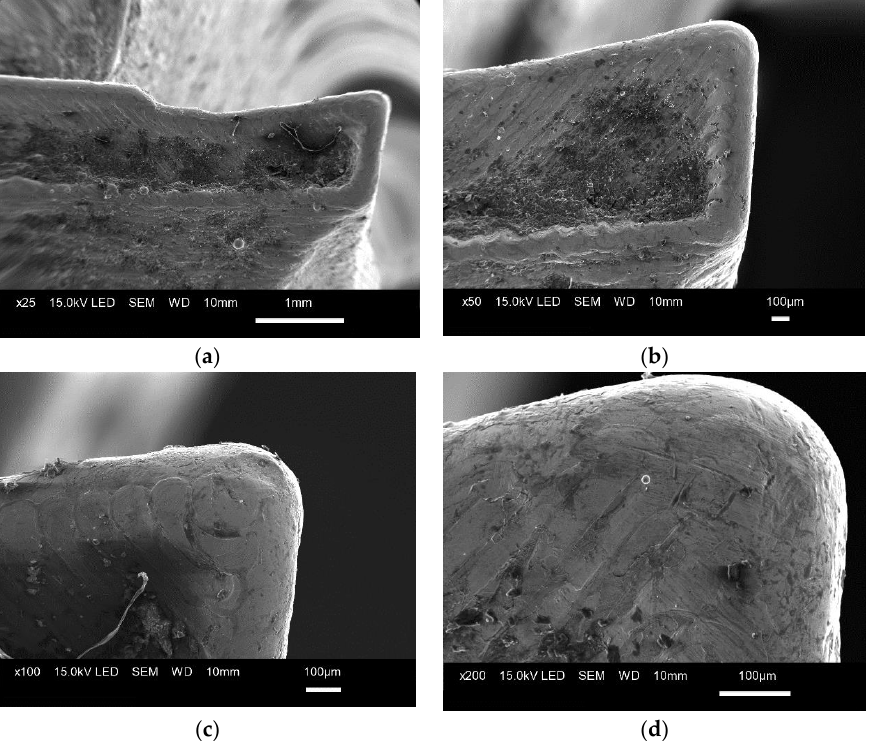
Figure 14. Microscopic images of the cutting edge magnified ( a ) 25×, ( b ) 50×, ( c ) 100×, ( d ) 200×. The microscopic analysis confirmed that grinding was necessary to sharpen the cut- ting edges of the additively manufactured tool before it was used for cutting purposes. Figure 15 shows microscopic scans of the tool structure after grinding.